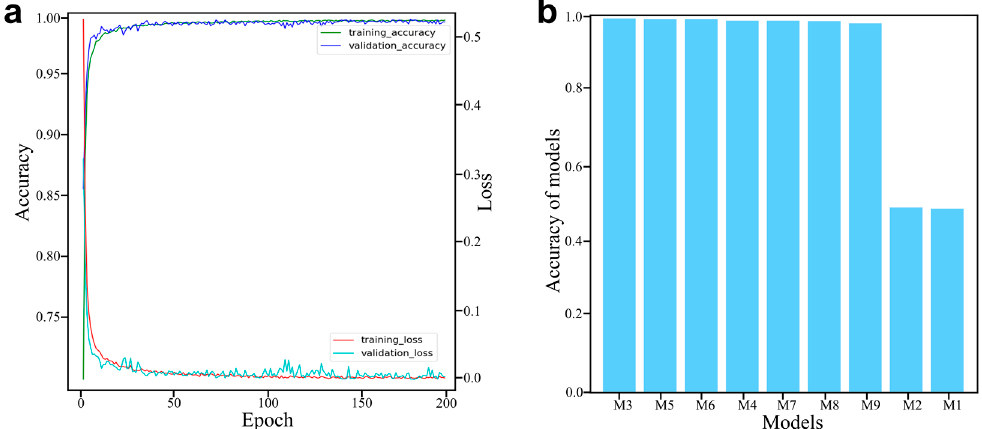
Figure 4. Optimization of the pSCNN model. ( a ) The accuracy curves and loss curves of training set and validation set. ( b ) The accuracy of different models on the validation set. Table 1. The accuracy of different pSCNN models on the validation